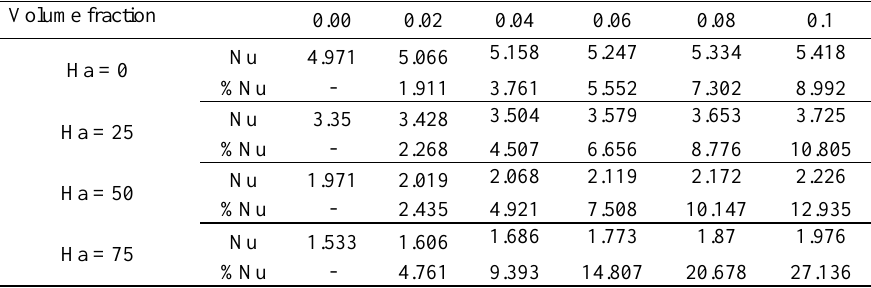
Table 5. Average Nusselt as a function of volume fraction and Hartmann number for the CuOwith : Re = 100, Pr = 0.71, Ri = 3 and J = 0 Volume fraction 0.00